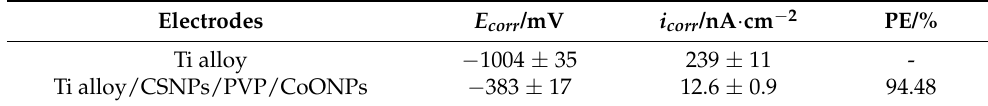
Table 3. Corrosion parameters of bare and coated Ti alloy in artificial saliva solution after 336 h of immersion at 37 ◦